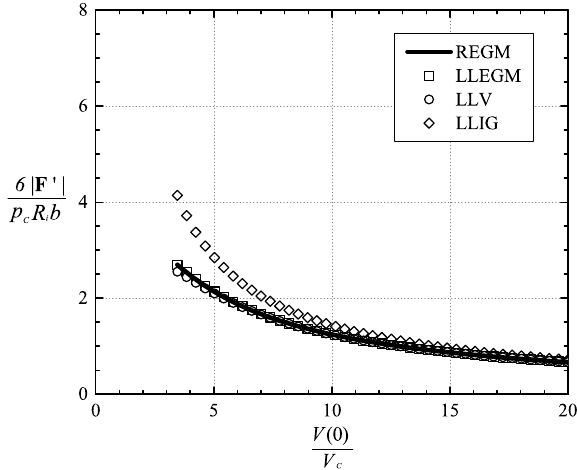
Figure 6. Scaled load vs. reference specific volume V / V c at T ref = 1.05 T c . The speed number Λ = 50 and the parameter δ =